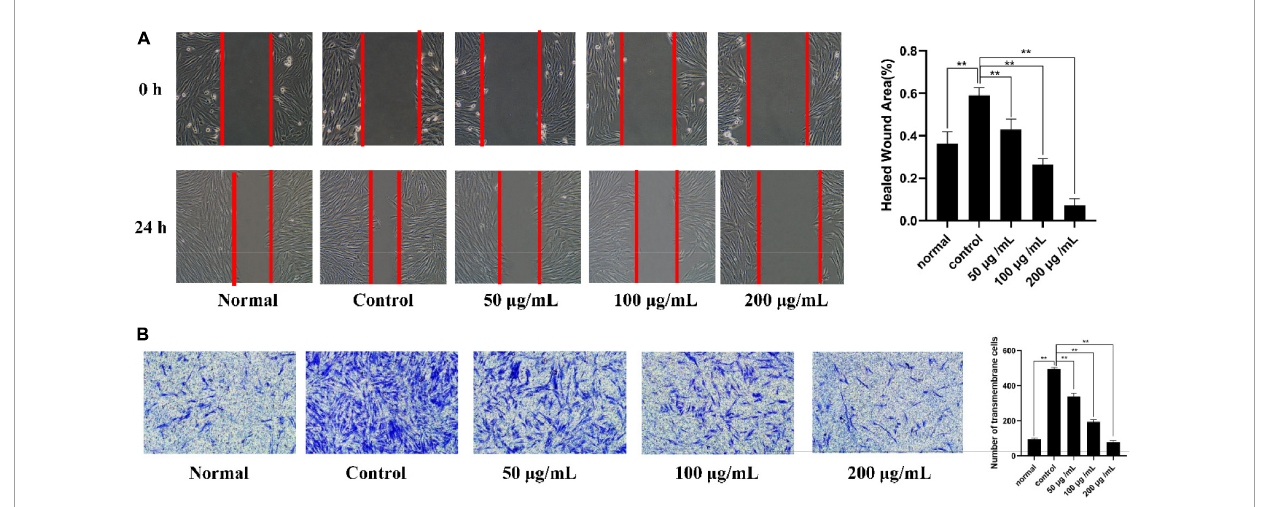
FIGURE8 Mechanism investigation of PKP2-1 in anti-inflammatory activity based on MH7A cells. (A) Statistical results of the effect of PKP2-1 on the migration of MH7A cells; (B) Transwell chamber detection of the effect of PKP2-1 on the migration of MH7A cells. MH7A cells were treated with TNF- α (20 ng/mL) and PKP2-1 (50, 100, and 200 µ g/mL) for 24 h, Data were represented as Mean ± SD ( n = 3), ** p < 0.01, vs. Control cells (MH7A cells treated by TNF- α alone).